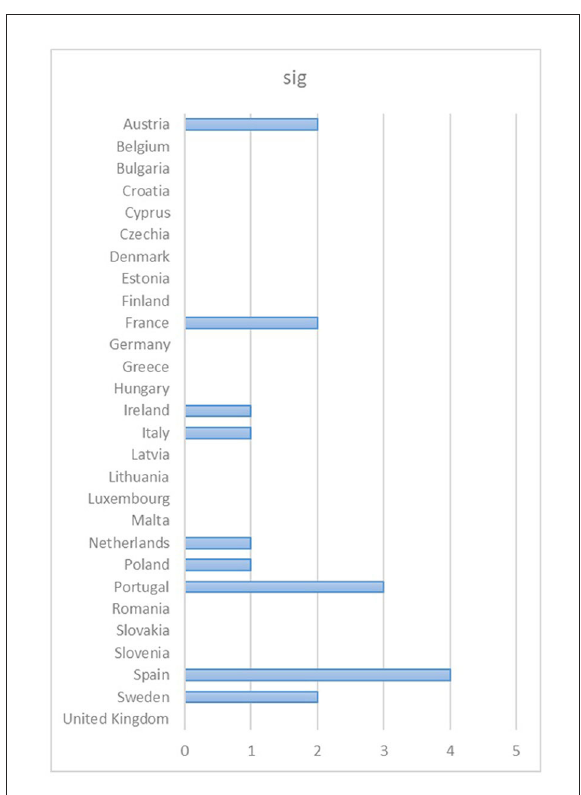
FIGURE1 Changes in search trends on the designated day in the different European countries. Source: Compiled by the authors with data extracted from GT (2022).